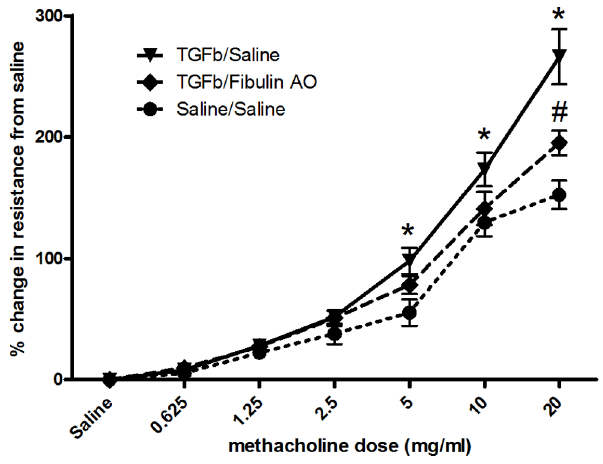
Figure 12. FBLN-1 contributes to the airway resistance of mice treated with TGF b . Adult BALB/c mice (6–8 weeks old) were treated twice (day 0 & 1) with either recombinant human TGF b or PBS. Seven mice were treated with the FBLN-1 AO daily for the first 7 days, and then 3 times weekly for the following three weeks. Specific airway resistance to methacholine was measured using whole body plethys- mography. Data are expressed as percentage change compared with PBS and shown as mean 6 SEM. n=7 for all groups except saline/saline for which n=6. TGF b /Saline is significantly greater than saline/saline (denoted by *) at 5, 10 and 20 mg/ml methacholine, p , 0.05, p , 0.01, p , 0.001 respectively. TGF b /FBLN-1 AO is significantly reduced (denot- ed by # ) compared with TGF b /Saline at 20 mg/ml methacholine p , 0.05.